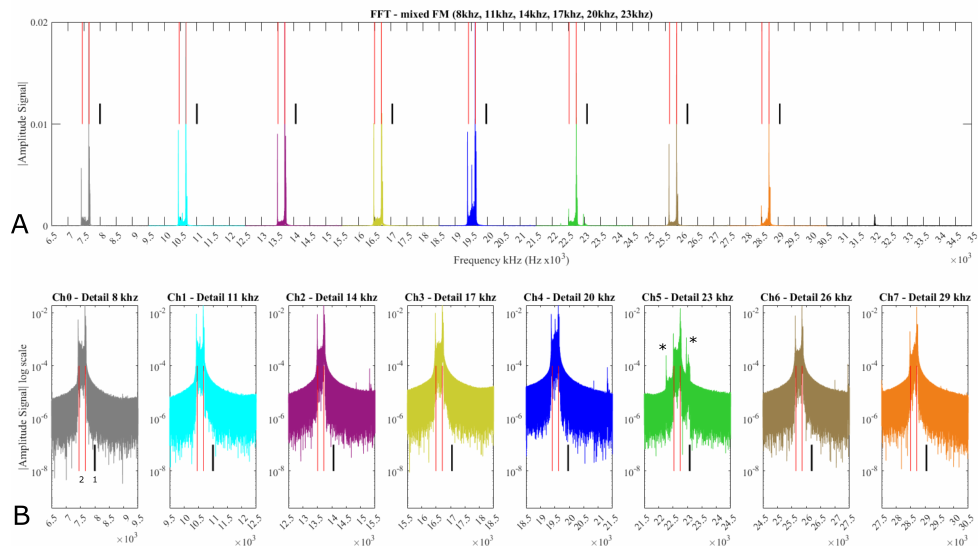
Figure 12. FFT analysis of the mixed FM signal. ( A ) represents the FM spectrum in normal scale. ( B ) in Log scale. The small vertical line (in black (1)) shows the carrier frequency position. The two thinner red lines (2) identify the peaks of the frequency deviations at − 333 and − 500 Hz from the carrier frequency that correspond to the sensor outputs 2.5 and 4 V